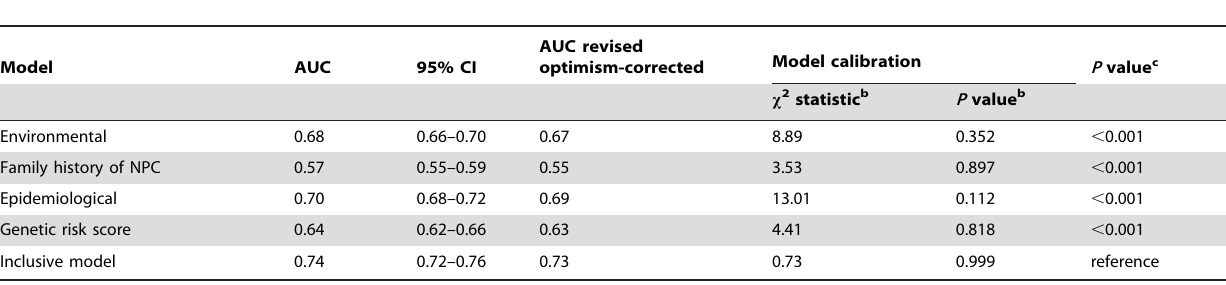
Table 3. Area under curves (AUC) as a measure of predictive strength for risk-prediction models based on different indicators a